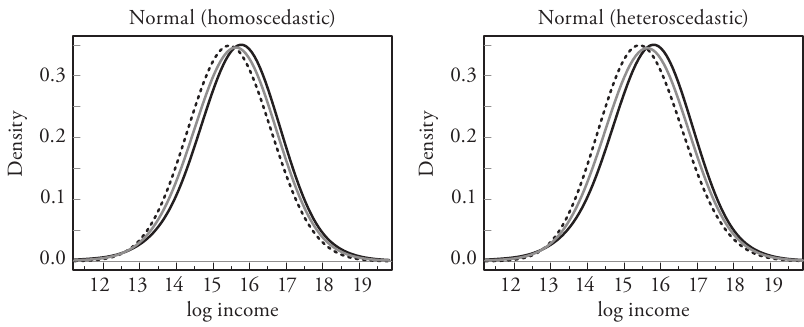
Figure 3: Normal distributed densities under homo- and